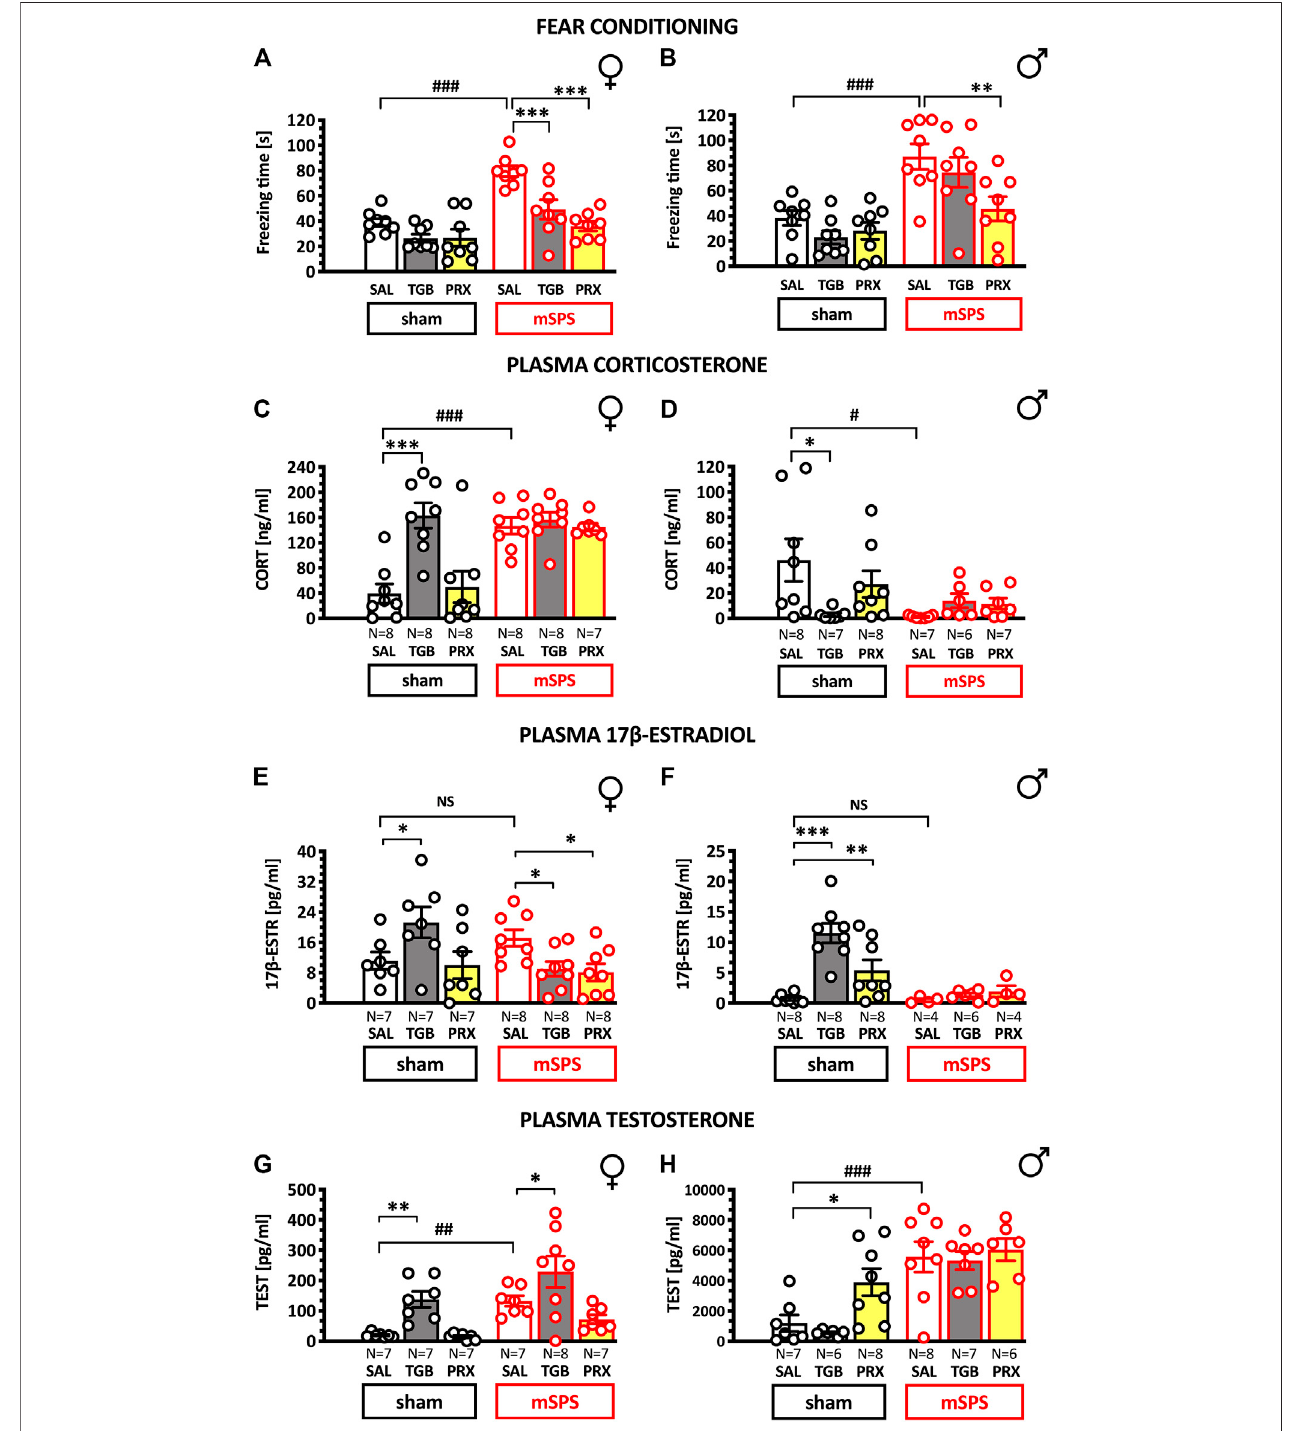
FIGURE2| Effectsof13 daystreatmentwithpramipexoleandtiagabineonfreezingdurationinthefearconditioningtest (A,B) ;corticosterone (C,D) ,17 β -estradiol (E,F) and testosterone (G,H) plasma levels in female and male mice subjected to PTSD-like set of stressors two weeks earlier. Mice were exposed to mSPS or sham mSPS, and 24 h later, the 13 days long treatment with saline (SAL), tiagabine (TGB; 10 mg/kg, i.p.) or pramipexole (PRX; 1 mg/kg, s.c.) has started. Drugs were given once daily at 8:00 – 9:00 AM. Following fear conditioning performed on days 14 – 15, animals were decapitated, and the blood samples were collected. Results are presented as means ± SEM. Data were analyzed using contrast analyses following 3- or 2-way ANOVA. Note different maximum ordinate values for female and male micedata.Symbols:* p < 0.05,** p < 0.01,*** p < 0.001vs.salinegroupstestedinthesamestressconditions; # p < 0.05, ## p < 0.001vs.same-treatmentgroupstestedin sham mSPS conditions. Data below the quanti fi cation limit of hormonal assays were excluded from the analyses. Abbreviations: 17 β -ESTR – 17 β -estradiol, CORT — corticosterone, mSPS – mouse single prolonged stress, PRX – pramipexole, SAL – saline, TEST – testosterone, TGB – tiagabine.